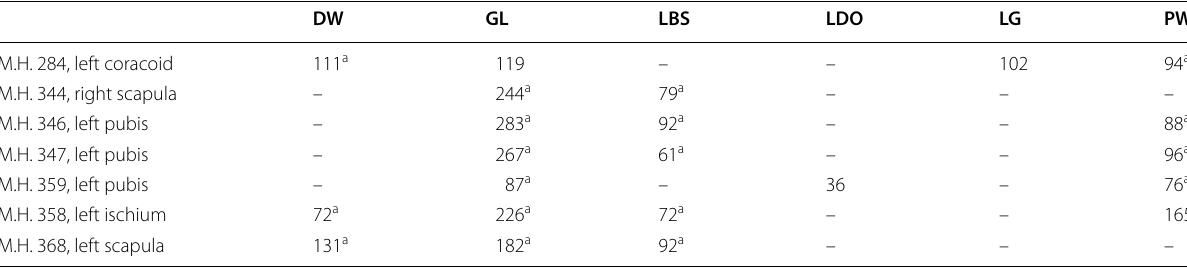
DW width of distal end ventral end of pubis and ischium, dorsal end of scapula/dorsoventral height of coracoid, GL greatest length/craniocaudal length of coracoid, = LBS least width of shaft, LDO largest diameter of obturator foramen (applies only to pubis), LG length of glenoid (applies only to scapula and coracoid), PW width of proximal end/at coracoid length of sternal articular surface a Indicates that the measurements refers only to preserved dimension at the incomplete bone